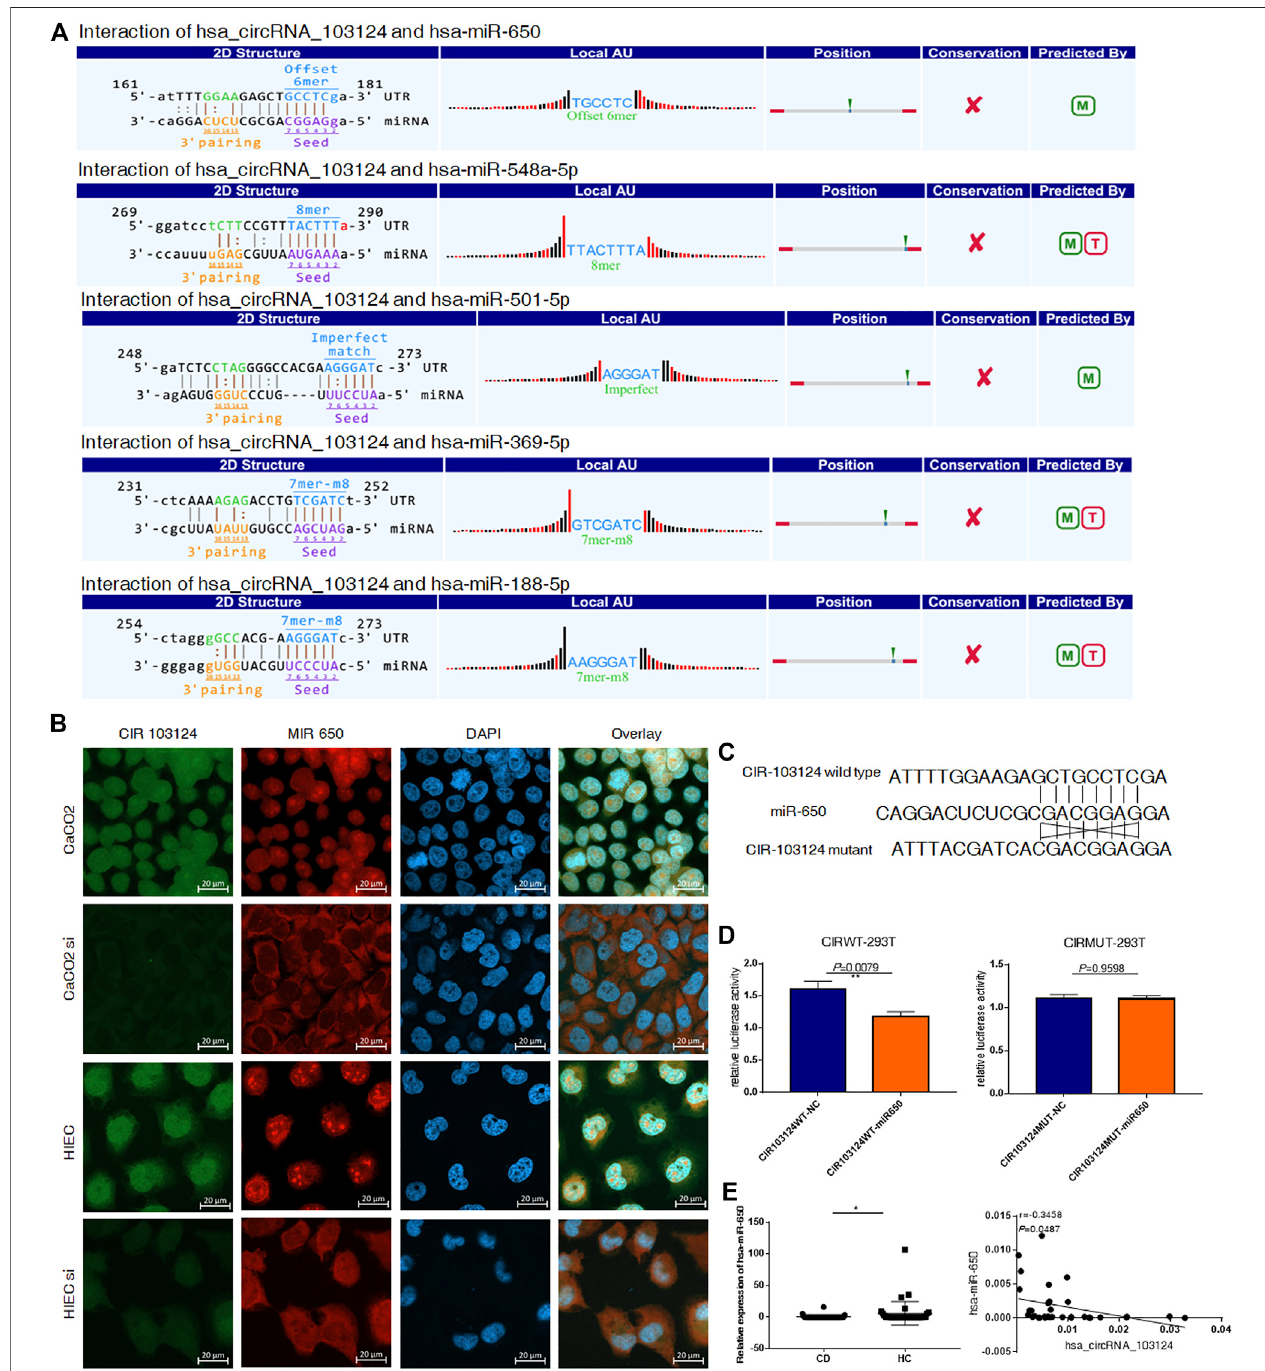
FIGURE 2 | Hsa_circRNA_103124 targeted hsa-miR-650. (A) The mircoRNA response element analysis of hsa_circRNA_103124 was conducted using TargetScan and miRanda. (B) FISH was performed to detect the location and expression level of hsa_circRNA_103124 and hsa-miR-650 in Caco2 cells and HIECs usingFAM-andCY3-labeledspeci fi cprobes,respectivelyinHEK293Tcells.Aconfocallaserscanningmicroscopewasusedtocapturethecellular fl uorescenceimages. Bar, 20 μ m. (C) The sequences of wildtype and corresponding mutated hsa-miR-650 MREs of hsa_circRNA_103124. (D) Relative luciferase activity of HEK293Tcellscotransfectedwiththehsa-miR-650mimicsandplasmidincludinghsa-miR-650MREofhsa_circRNA_103124,orHEK293Tcellscotransfectedwiththe hsa-miR-650 mimicsand plasmid including mutated sequences ofhsa-miR-650 MRE ofhsa_circRNA_103124. (E) Relative expression ofhsa-miR-650 in patients with CD ( n (cid:2) 43) or HCs( n (cid:2) 37) was detected using RT-QPCR. The correlation between hsa_circRNA_103124 and hsa-miR-650 expression ( n (cid:2) 33) was analyzed by calculating Pearson ’ s correlation coef fi cients. * p <